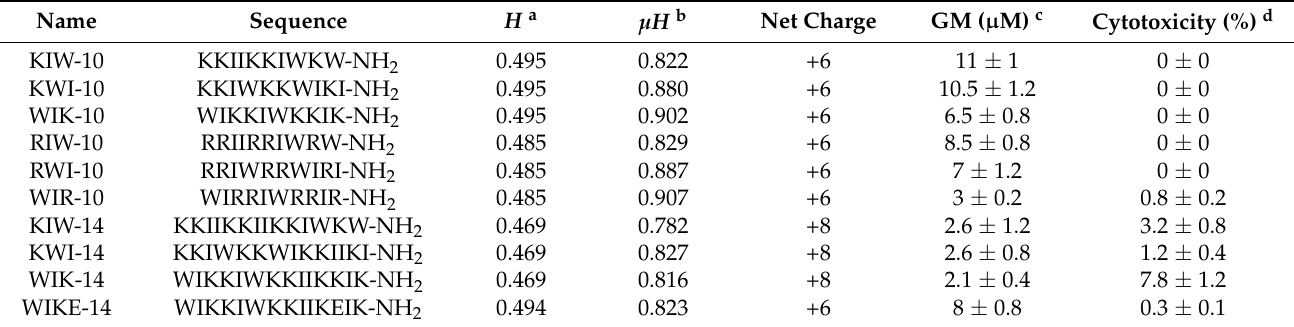
Table 1. Amino acid sequences, hydrophobicity ( H ), hydrophobic moment ( µH ), antimicrobial ac- tivity, and cytotoxicity of XIW peptides.